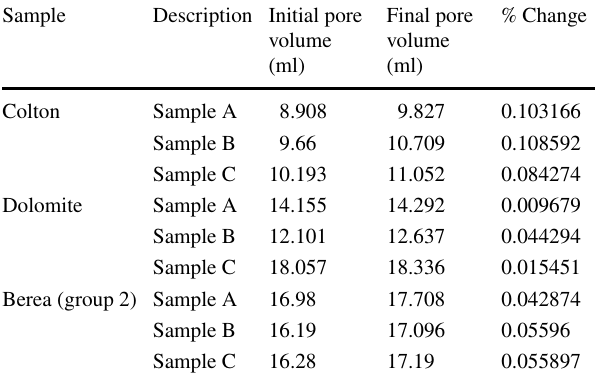
Table 5 Pore volume of core samples before and after acidizing